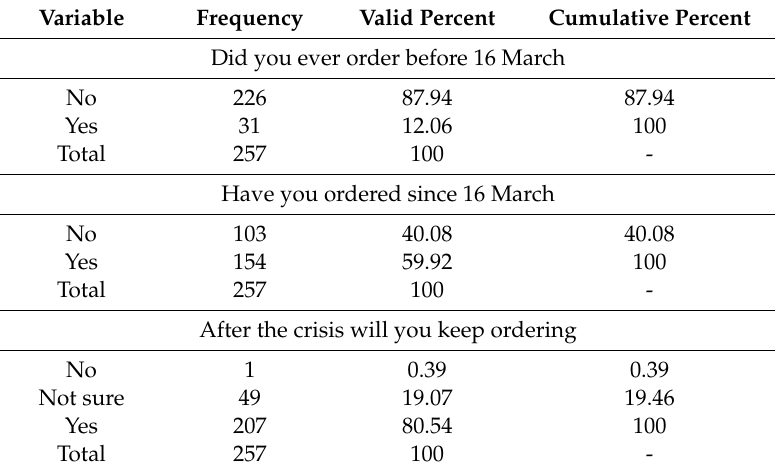
Table 3. The frequency of those who ordered before 16 March, those who have ordered after 16 March, and of those who will keep ordering after the end of COVID-19